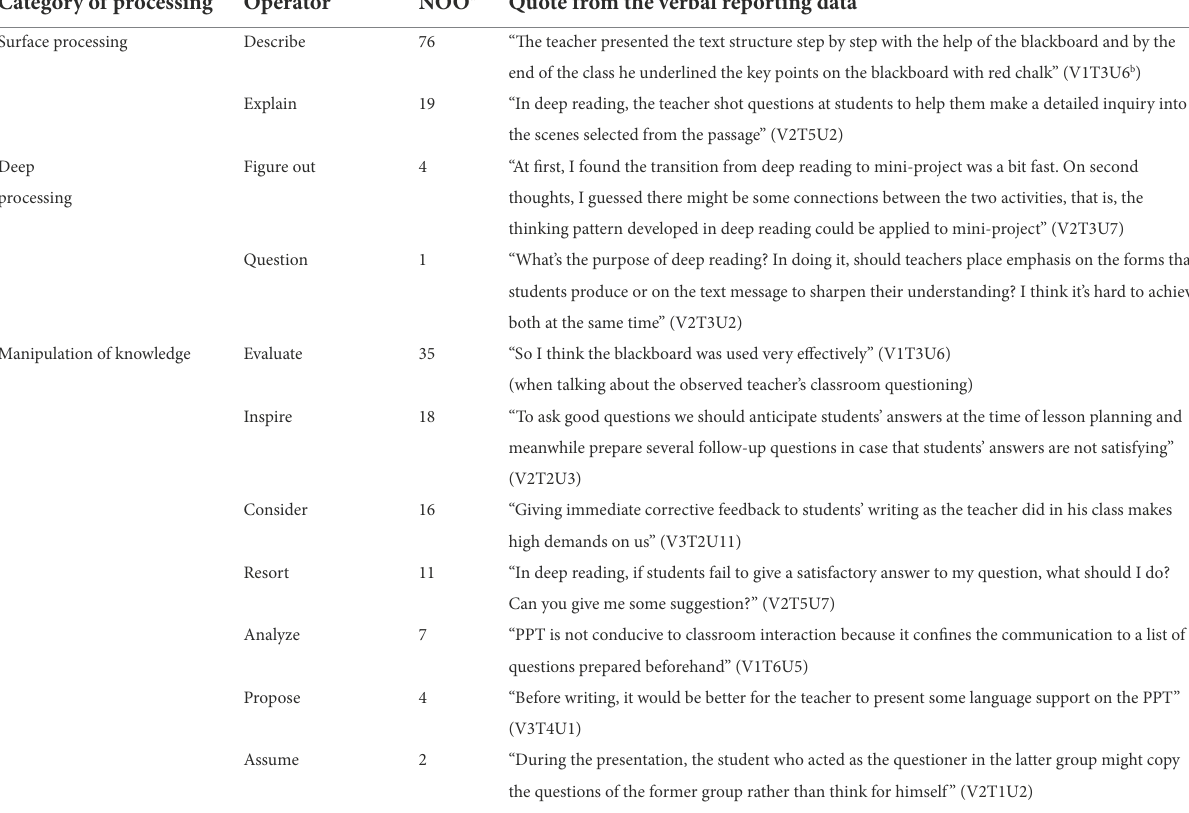
TABLE 4 The participating teachers’ cognitive activities.